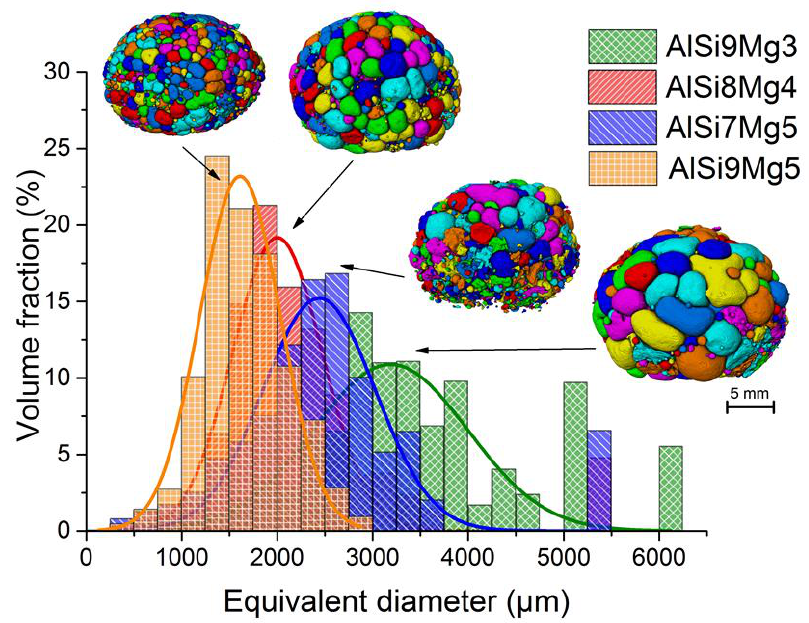
Figure 7. Volume-weighted pore size distribution histograms of four selected foams and corresponding Gaussian fits. Insets show rendered images of the segmented pore structures.